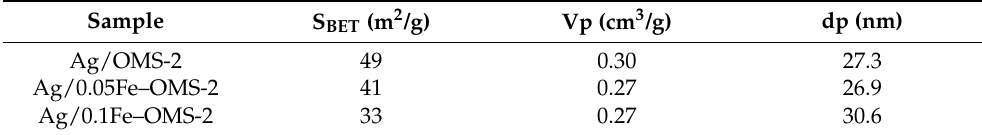
Table 3. Textural characteristics of the prepared